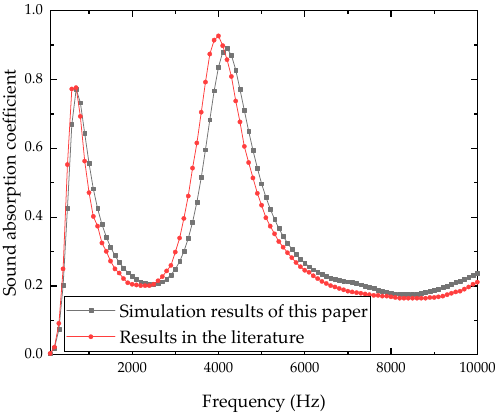
Figure 6. Comparison of the simulation results of this paper with the literature results.